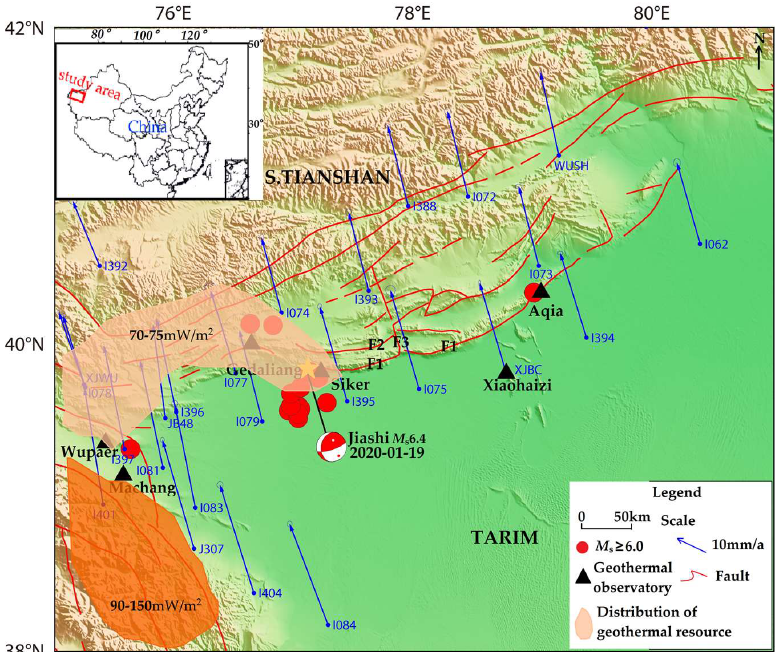
Figure 1. Overview of the study area. Red dots indicate M s ≥ 6.0 earthquakes since 1990, and the yellow star is the Jiashi M s 6.4 earthquake; Arrows show GNSS velocity fields for 2015–2019, the letters and numbers at the end of the arrow are the names of the observatory. F1: Kepingtage inverse fracture; F2: Ozgertawu inverse fracture; F3: Piqiang fault. The triangle is the ground temperature observation station. Red lines indicate faults. The distribution of geothermal resources was derived from the China Knowledge Center for Engineering Science and Technology (http://222.223.214.100:8067/GeoEnergy (accessed on 5 February